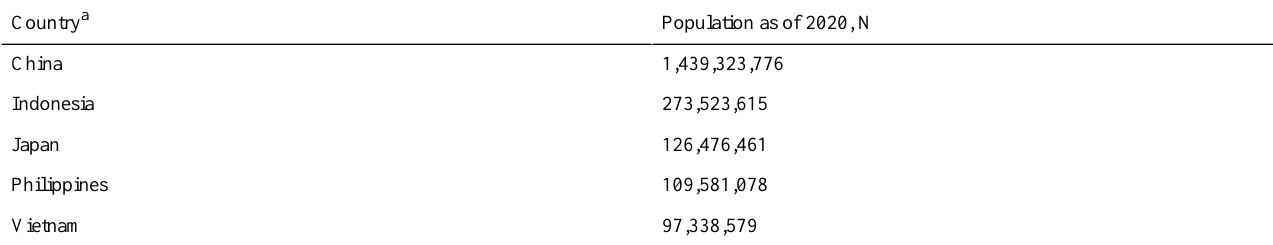
Table 7. Most populous East Asian